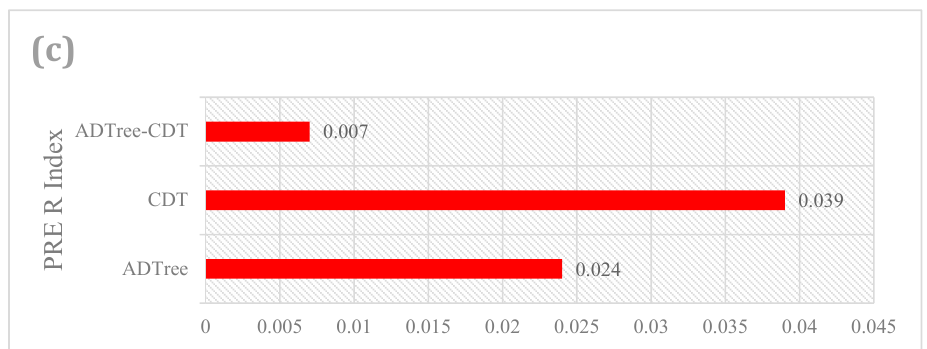
Figure 8. Robustness of models using ( a ) area under the curve, ( b ) accuracy (ACC), ( c ) precision (PRE).